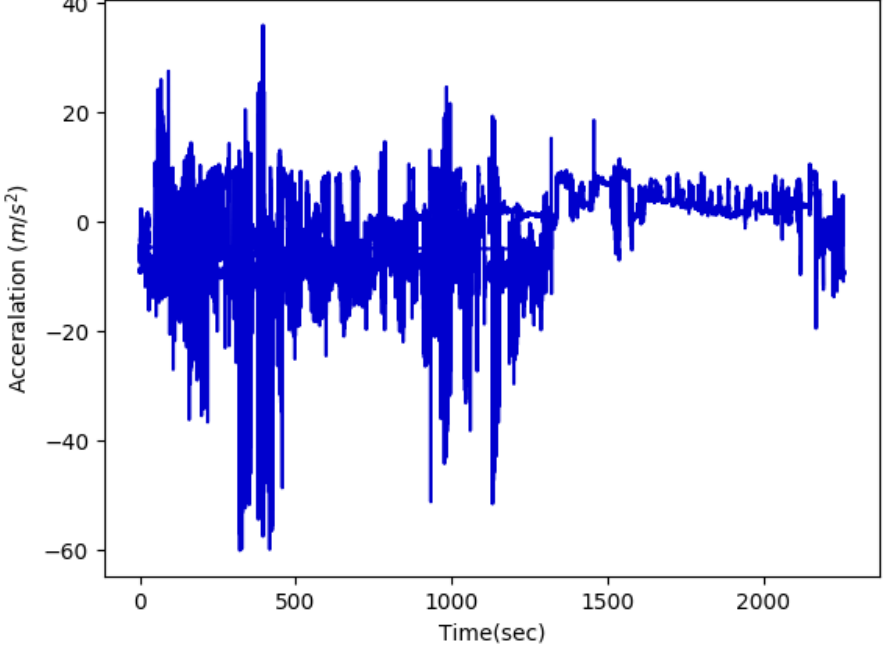
Figure 2. Example acceleration data extracted from